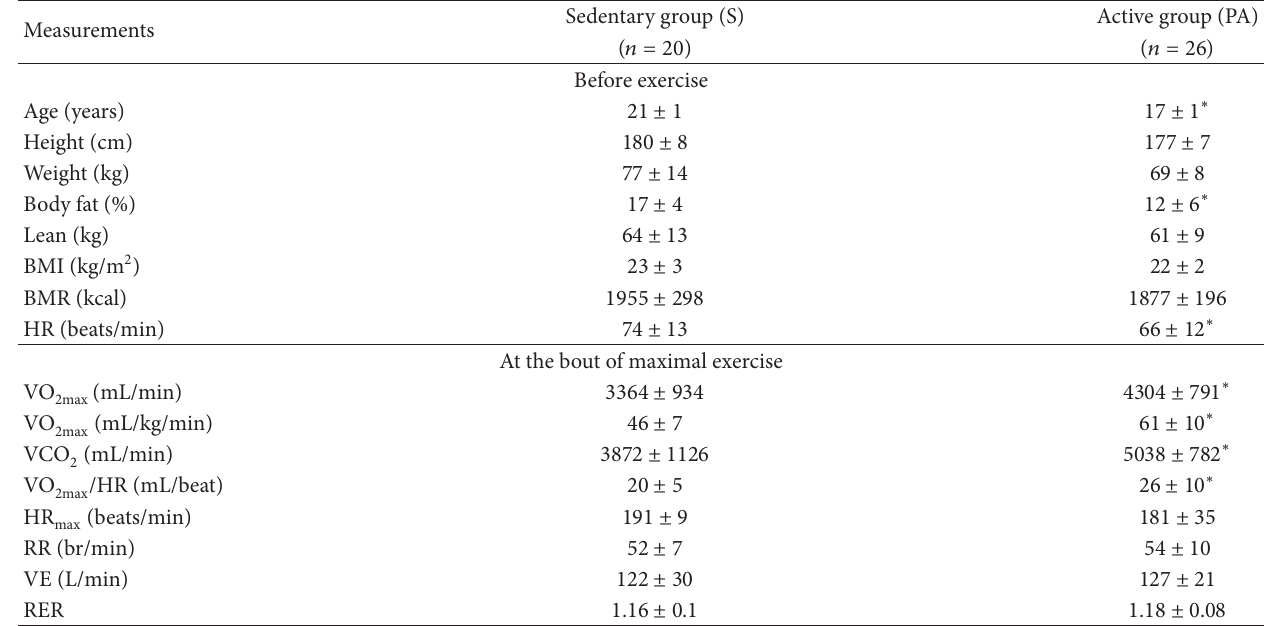
Table 1: Physiological measurements of the study groups (mean ± SD).